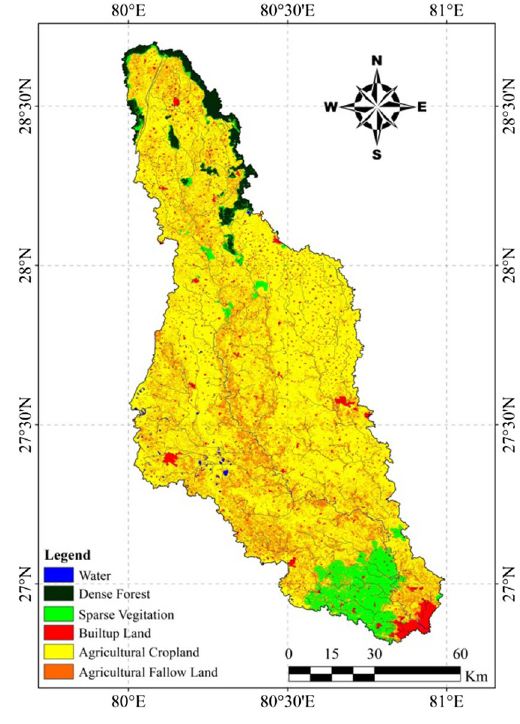
Fig. 5 Hydrometeorological stations with gauging